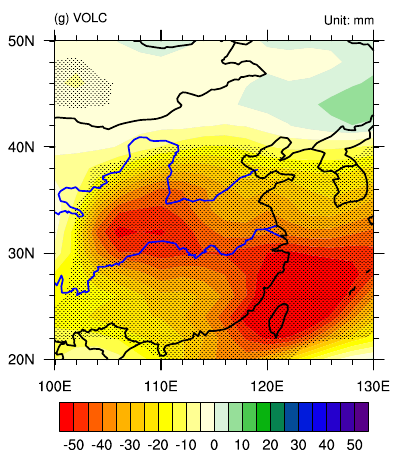
Figure 3. Simulated ensemble-averaged annual precipitation anomalies during the megadrought years over eastern China (unit: mm) from the long-term means of the Palmer Drought Severity Index (PDSI) ( a ), control (CTRL) run ( b ), all-forcing (ALL) runs ( c ), greenhouse gas (GHG) runs ( d ), land use and land cover (LULC) runs ( e ), spectral solar irradiance (SSI) runs ( f ), spectral solar and volcanic eruption (VOLC) runs ( g ). Stippling indicates differences significant at the p = 0.05 level based on a t -test. The black rectangle indicates the location of the study region. The blue lines indicate the locations of Yellow River (upper blue line) and Yangtze River (lower blue line).